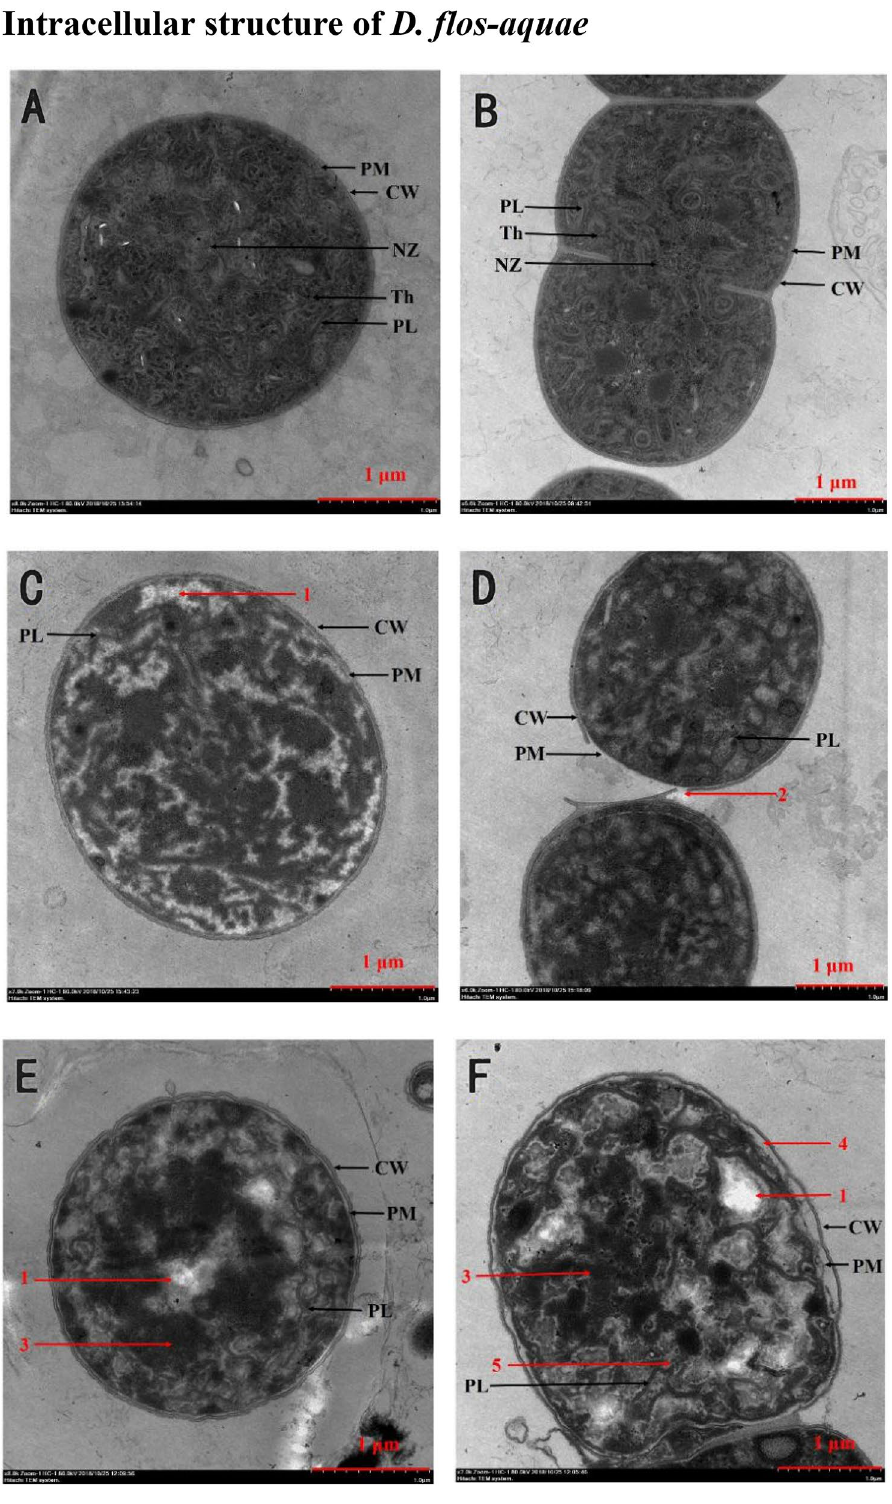
Figure 3. Representative TEM images of Dolichospermum flos-aquae cells treated with 0 g L −1 and 5.4 g L −1 aqueous extract of watermelon peel (WMPAE). ( A ) ( B ), normal cells in 0 g L −1 WMPAE group. ( C , D ), cells in 5.4 g L −1 WMPAE group after 24 h exposure. ( E , F ), cells in 5.4 g L −1 WMPAE group after 48 h exposure. (Abbreviations and arrows number indicate: plasma membrane, (PM); cell wall, (CW); photosynthetic lamellae, (PL); nucleoid zone, (NZ); Thylakoid, (Th); 1, vacuolation; 2, disconnection between cells in filaments; 3, pyknosis formation; 4, the separation of cell wall and plasma membrane; 5, blurring of photosynthetic